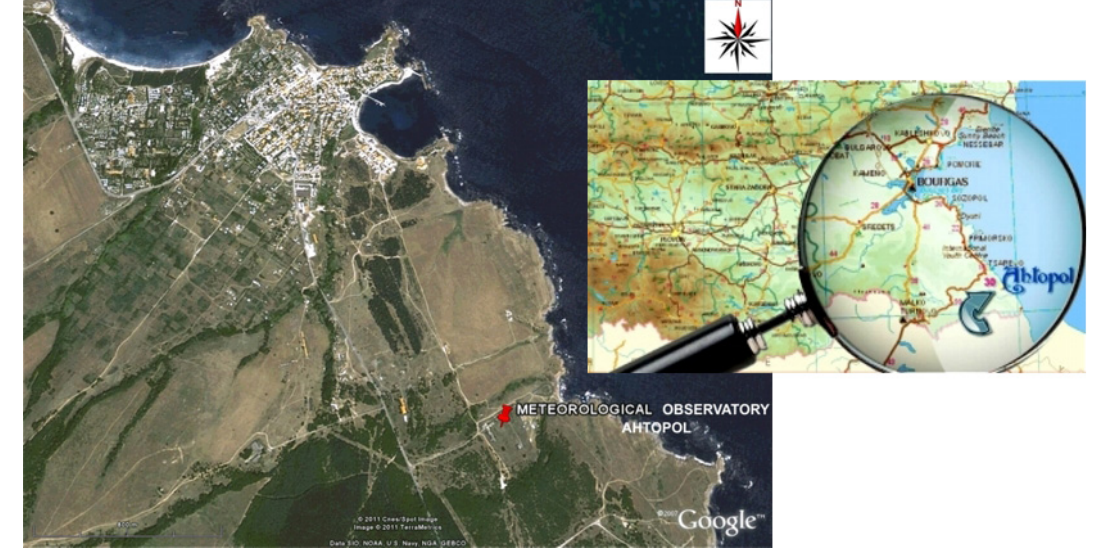
Figure 1. Location of the Meteorological Observatory of Ahtopol (60km south-east of Burgas) and Google map of the